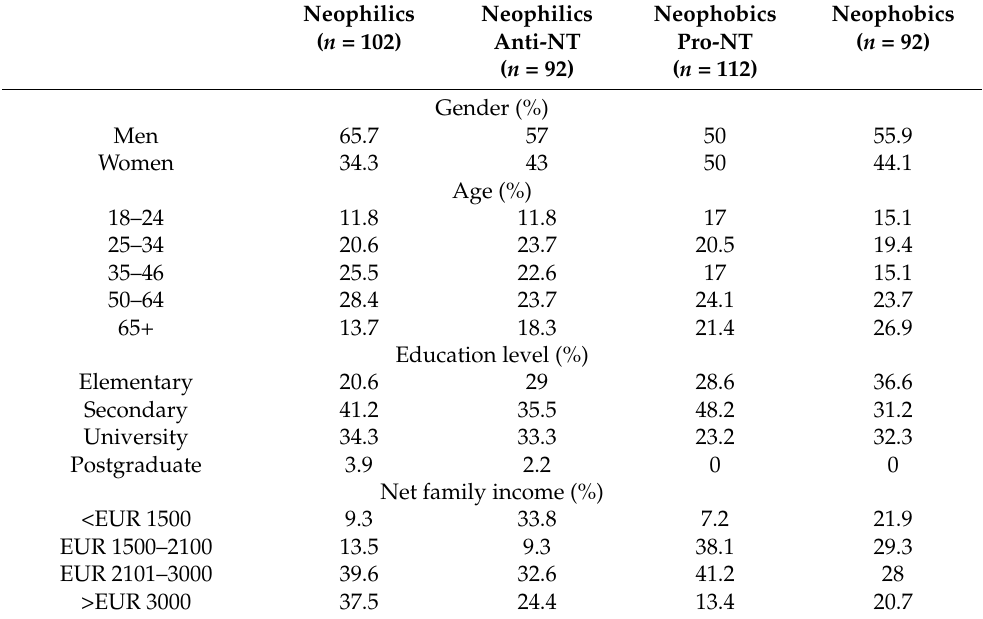
Table 5. Socioeconomic characteristics of the segments (%).